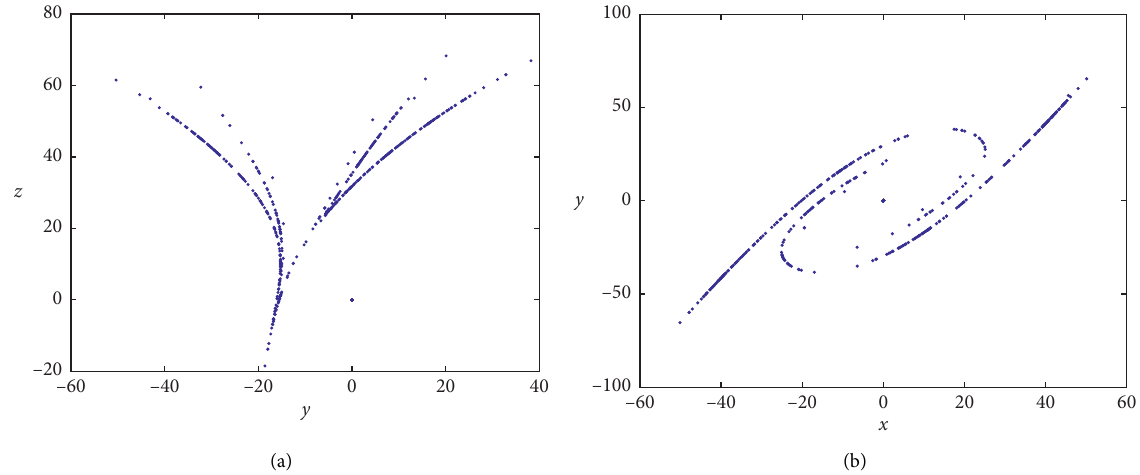
Figure 7: Poincare sections of the system: (a) x � − 10 and (b) z � 50.